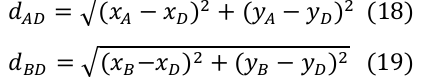
Fig. 5. Tracking a Single Target with Intersections of Hyperbolic